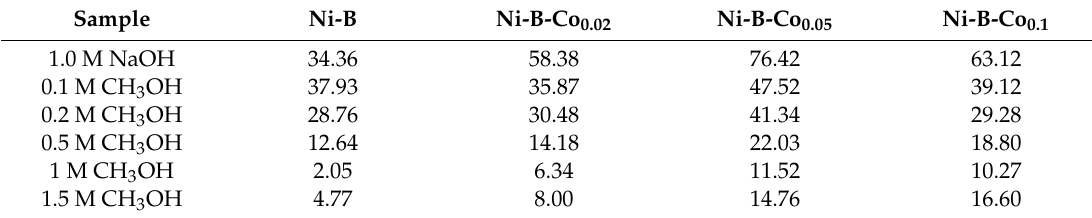
Table 3. The reduction peak currents (A g − 1 ) on Ni-B and Ni-B-Co